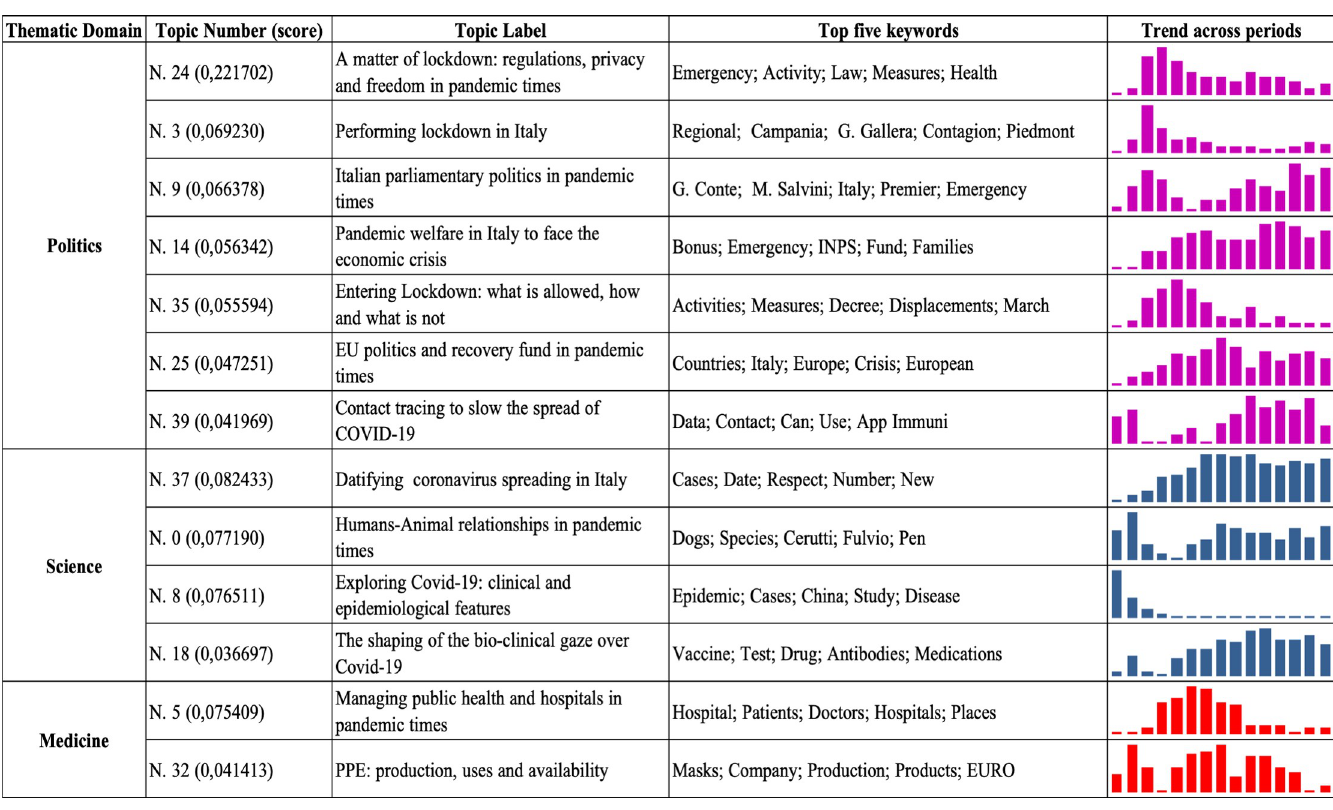
Fig 4. Topics clustered per thematic domain; score (posterior document-topic density), keywords, and trends across the 15 periods were considered.